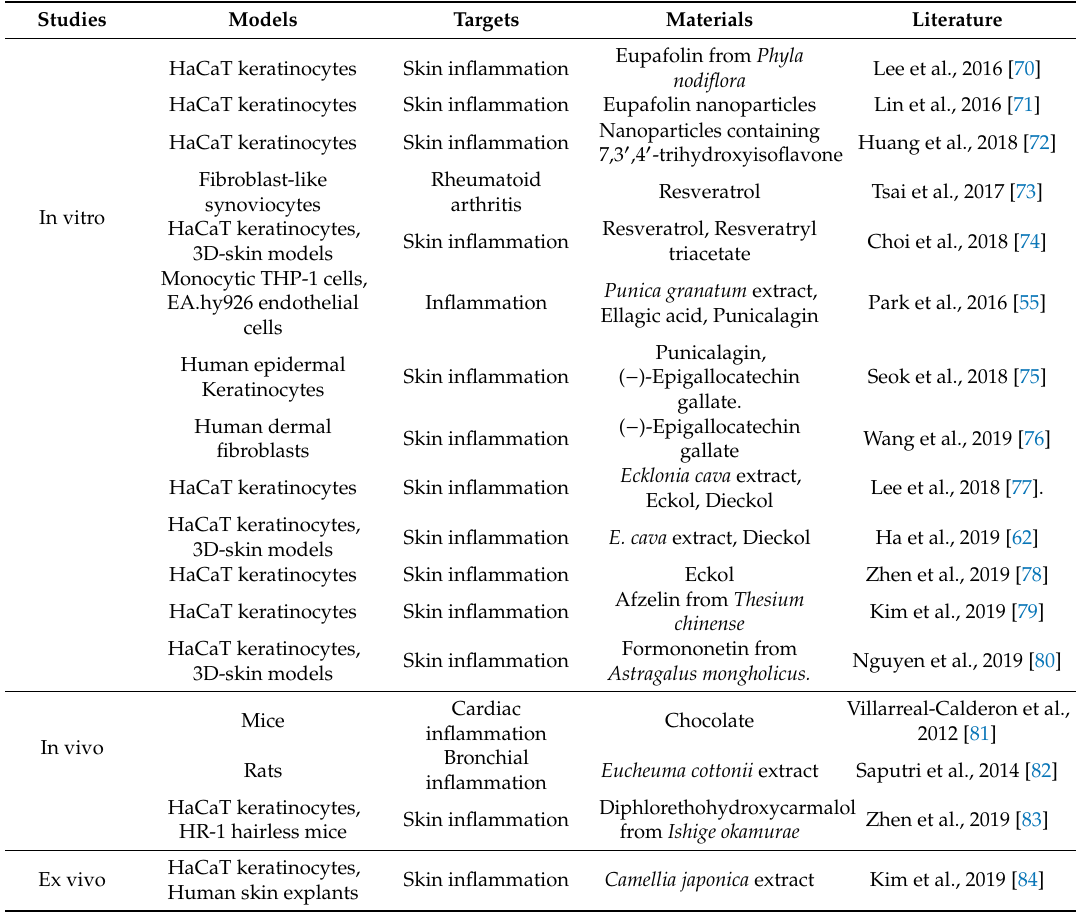
Table 1. Protective e ff ects of plant extracts and phenolic compounds against oxidative stress and inflammation induced by airborne